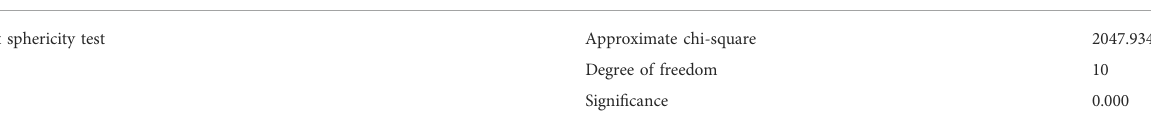
TABLE 2 KMO, Bartlett sphericity test. KMO Sampling Suitability